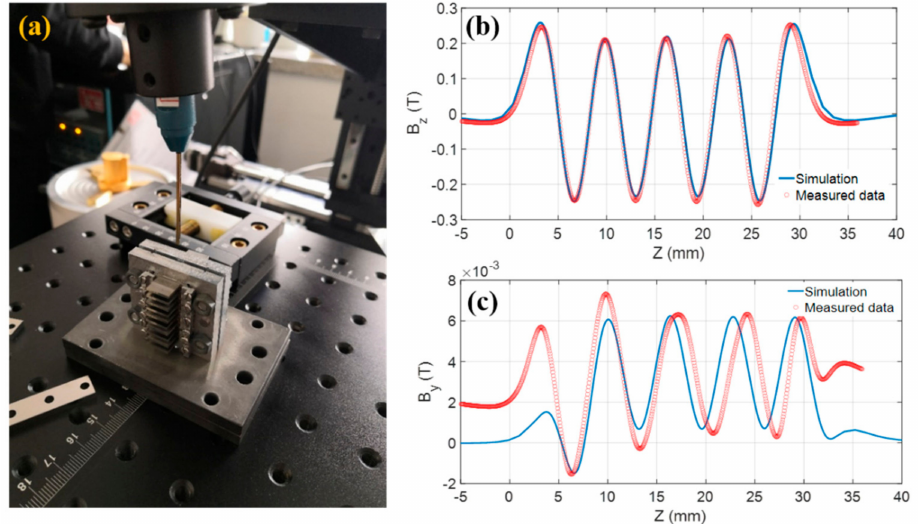
Figure 9. ( a ) The magnetic field measurement platform, ( b ) the measured axial magnetic field distribution B z , and ( c ) the measured side magnetic field B y